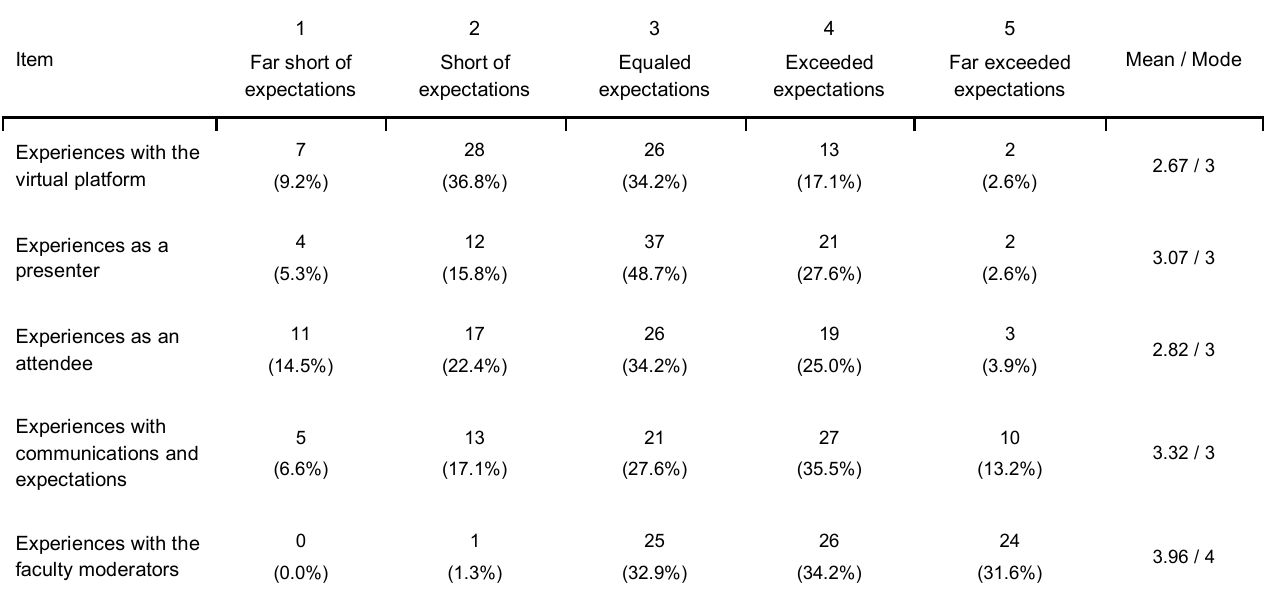
Table 1: Frequencies and Percentages of Response for Feedback from Students Immediately Following the 2017 DRC